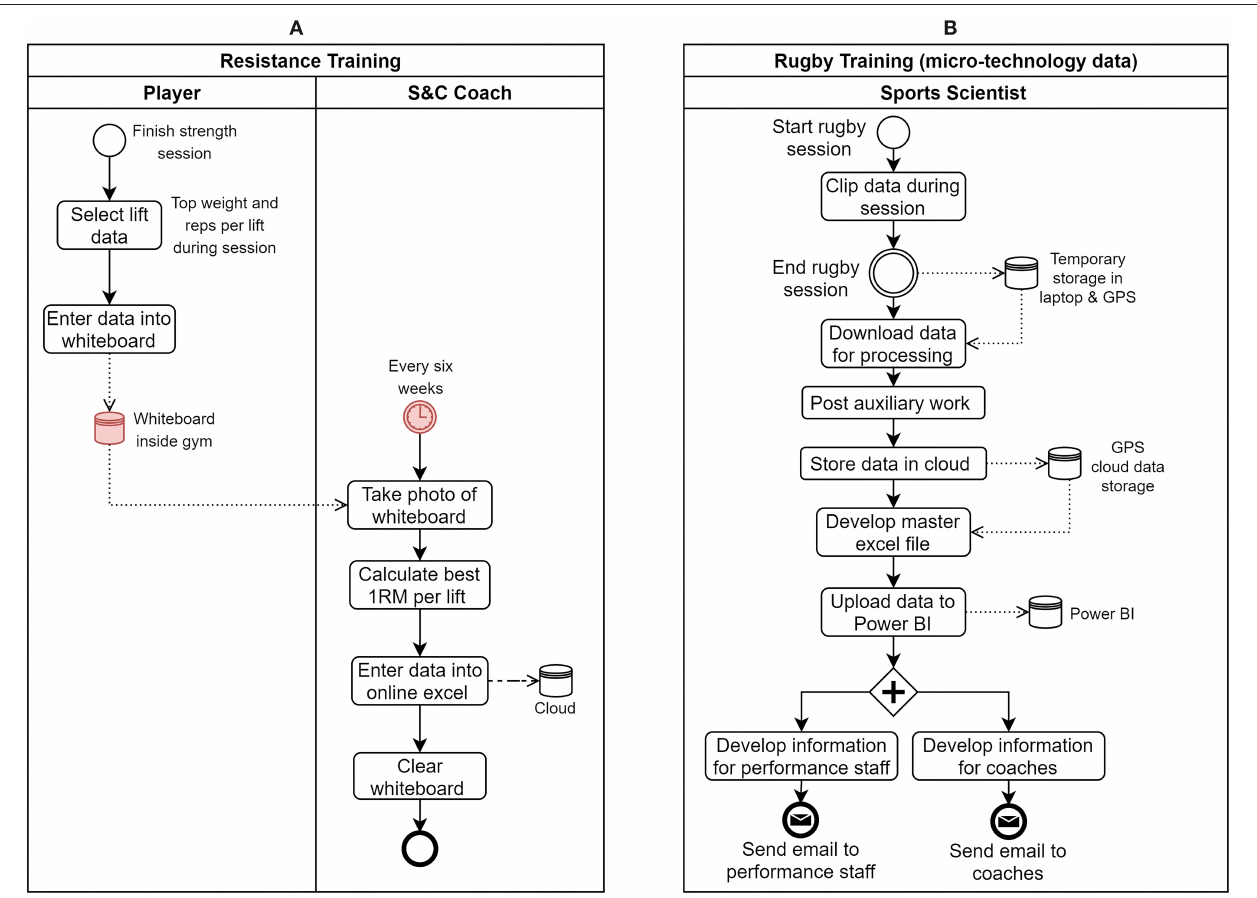
FIGURE 7 | As-Is state process models of (A) resistance training (potential issue points contain a red background) and (B) rugby training micro-technology data collection processes.